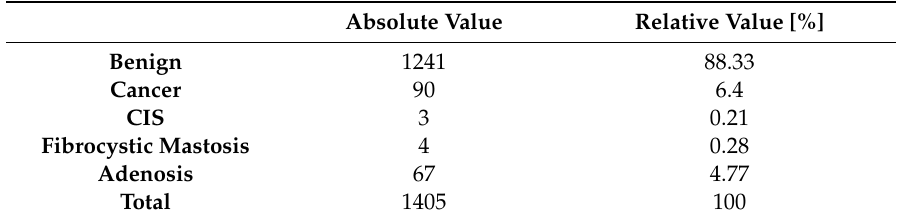
Table 1. Malignancy results for the considered nodules.